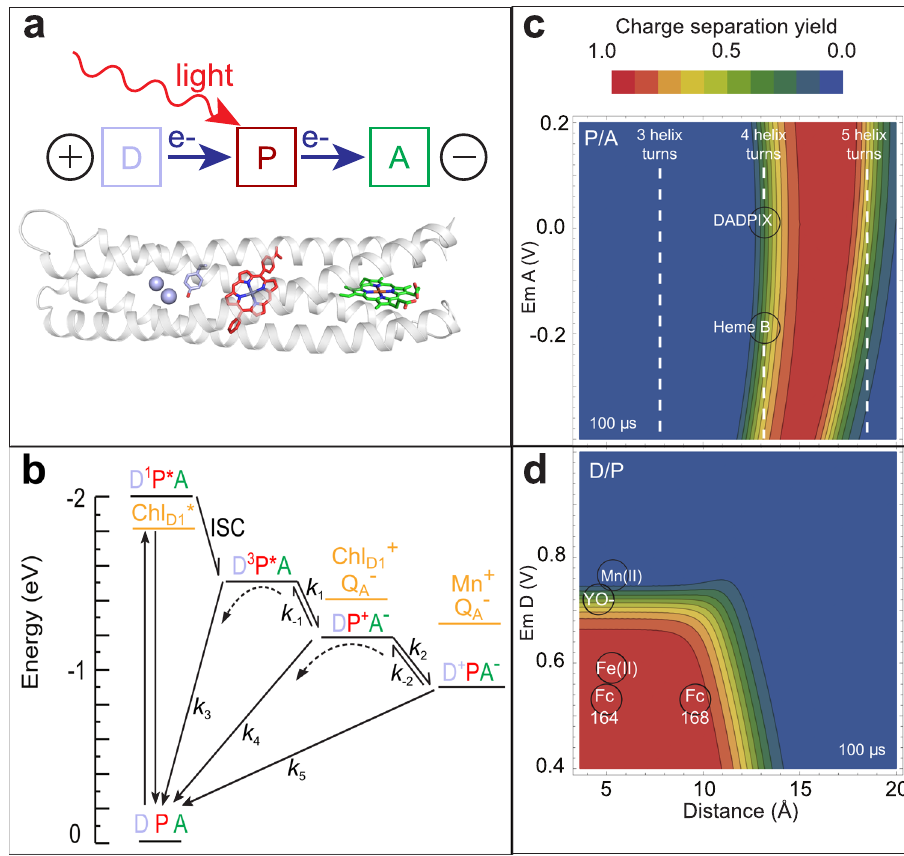
Fig. 1 | Design of natural and arti fi cial photosynthetic reaction centers. a The light-activated donor-pigment-acceptor (DPA) electron transfer triad core of pho- tosynthesisandX-raycrystalstructureat2.0ÅresolutionoftheRCmaquettewitha metal ion/tyrosine donor, Zn porphyrin pigment, and heme B acceptor (PDB ID: 5VJS). b Kinetic schemes of a light-activated system show energies plotted relative togroundstatebeforelightactivation.AnRCmaquetteDPAtriadiscomparedwith representative PSII charge separated states (orange) 74 . c Triad contour plots of